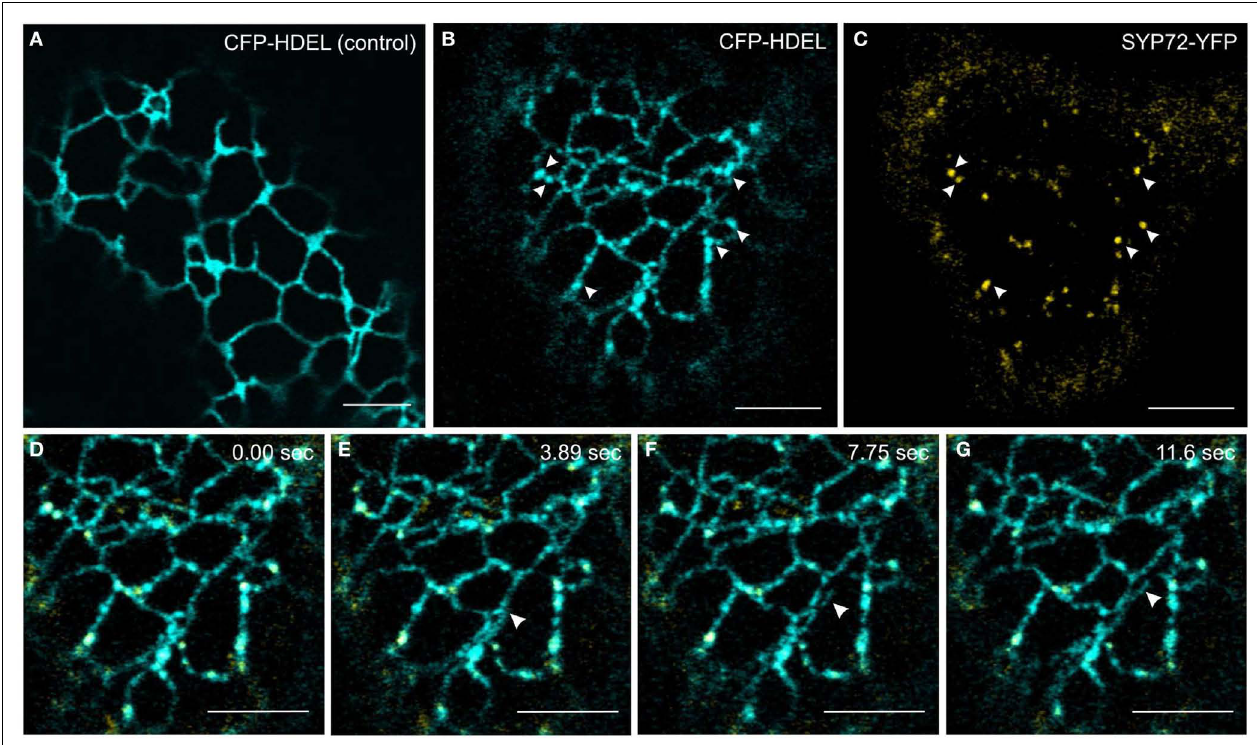
nodules with SYP72-YFP punctae. (D–G) Frames of a movie (CFP-HDEL in cyan; SYP72-YFP in yellow) depicting a growing tubule (arrowhead; Movie S1 in Supplementary Material). Magnification bars = 5 µ m (A–G)